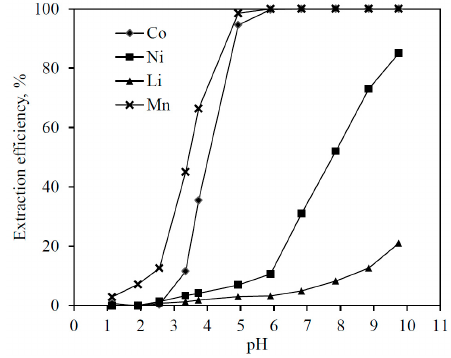
Figure 1. pH isotherm of lithium ion batteries leaching solution with Cyanex 272.